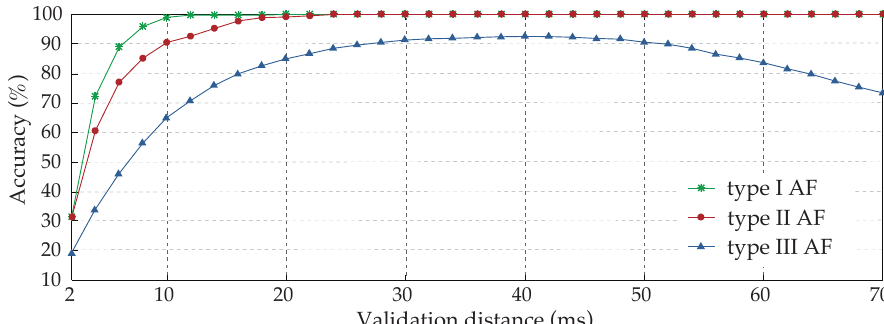
Figure 8. Study of the validation distance influence over annotation accuracy results for the three types of AF EGMs analyzed. Due to their complex nature, involving components of variable ampli- tude and frequency, type III EGMs are the most difficult to annotate